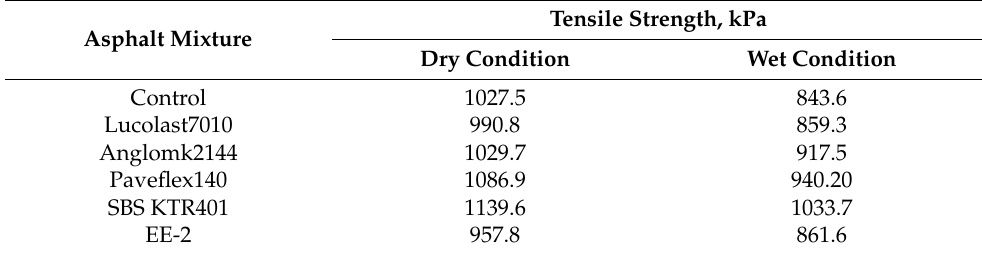
Table 14. Indirect tensile strength for different mixtures.